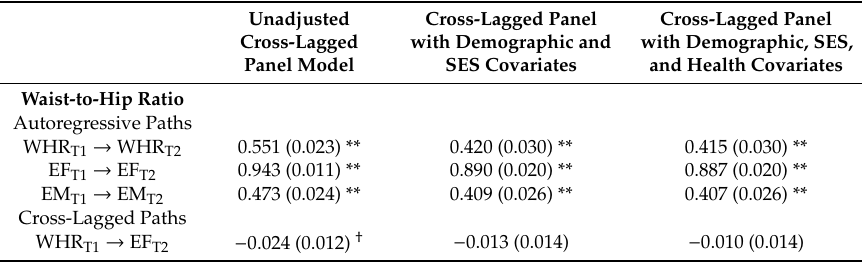
Table 3. Standardized autoregressive and cross-lagged paths coe ffi cients of obesity (waist-to-hip ratio and BMI) and the latent variables of executive function and episodic